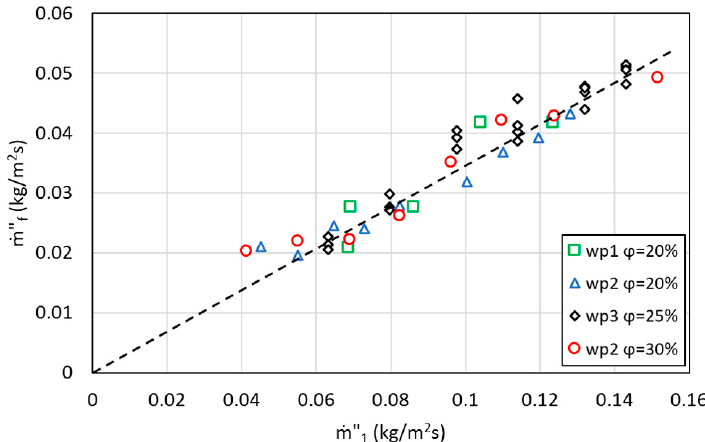
. m (cid:48)(cid:48) ). 1